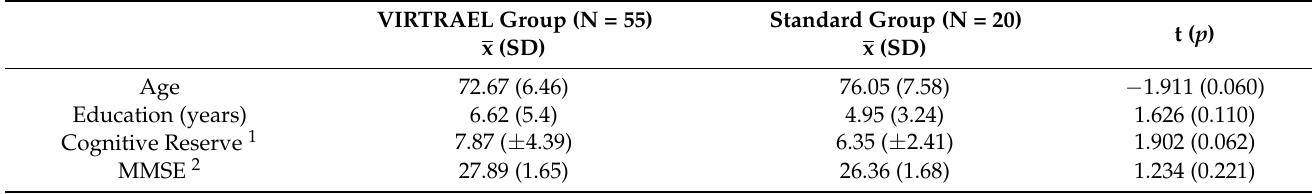
Table 1. Sociodemographics and general cognitive status of participants in both